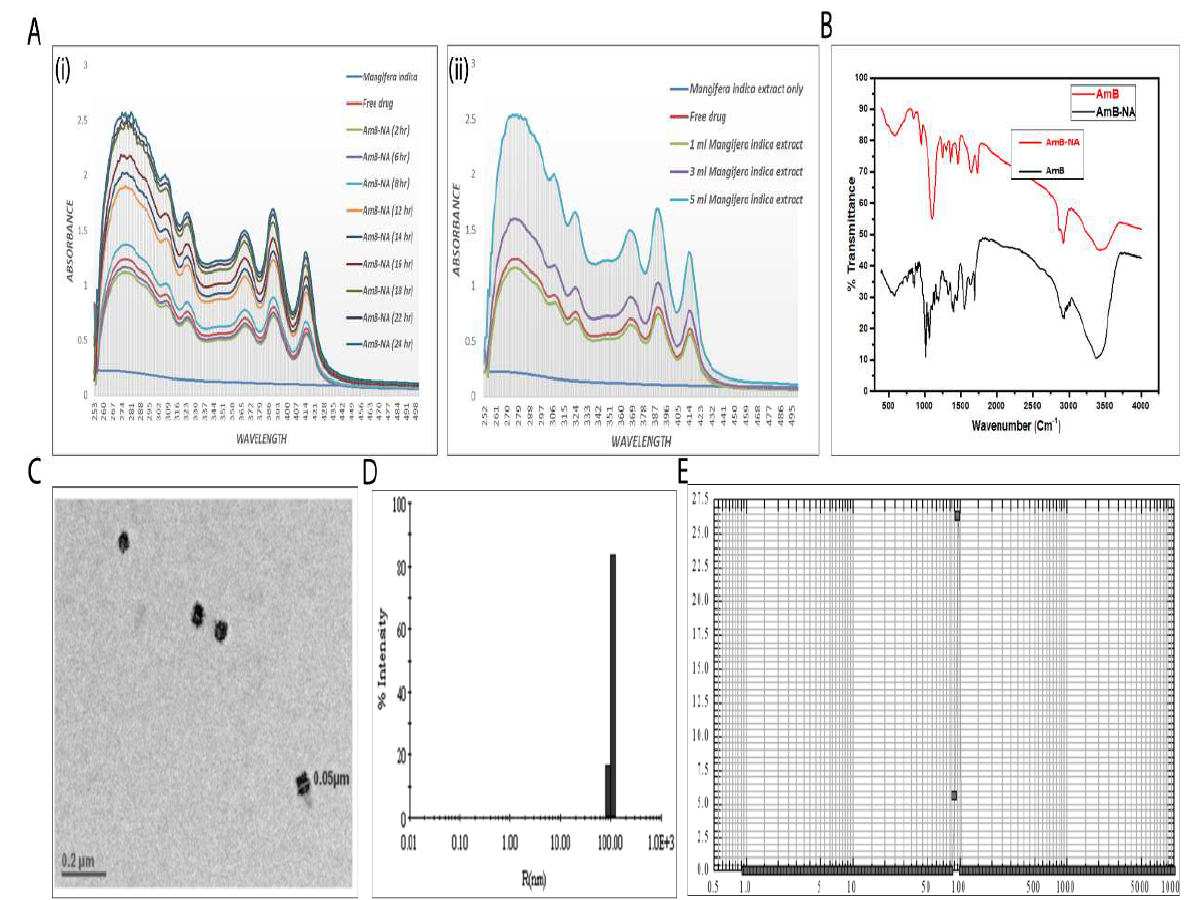
Figure 1. Physico-chemical characterization of the as-synthesized AmB-NA. The co-incubation of AmB with Mangifera indica fruit pulp resulted in the green synthesis of AmB-NAs. ( A ) Effect of various parameters influencing synthesis and physico-chemical properties of the as-synthesized AmB-NA ( i ) Time kinetics of AmB-NA synthesis as determined on the basis of the UV-VIS spectrophotometric analysis, ( ii ) Concentration-dependent kinetics of as-synthesized AmB-NA was monitored by co- incubation of 1 mM AmB with the increasing volume of the stock of Mangifera indica fruit pulp extract. ( B ) The IR-spectrum of the as-synthesized AmB-NAs showing characteristic functional groups of the parent AmB compound along with residues of fruit pulp in the as-synthesized AmB-NAs, ( i ) FTIR absorption spectra of as-synthesized AmB-NA formulation ( C ) Size distribution and morphology of the as-synthesized AmB-NA as revealed by representative TEM image of the as-fabricated AmB-NA synthesized by employing 5 mL of Mangifera indica pulp extract mixed with 5 mL of 1 mM AmB solution. ( D ) The average diameter of AmB-NA, determined by DLS measurements, was 97 ± 0.8 nm for AmB-NA. ( E ) Particle size distribution of AmB-NA assessed by photon correlation spectroscopy was estimated to be 101 ± 0.7 nm for